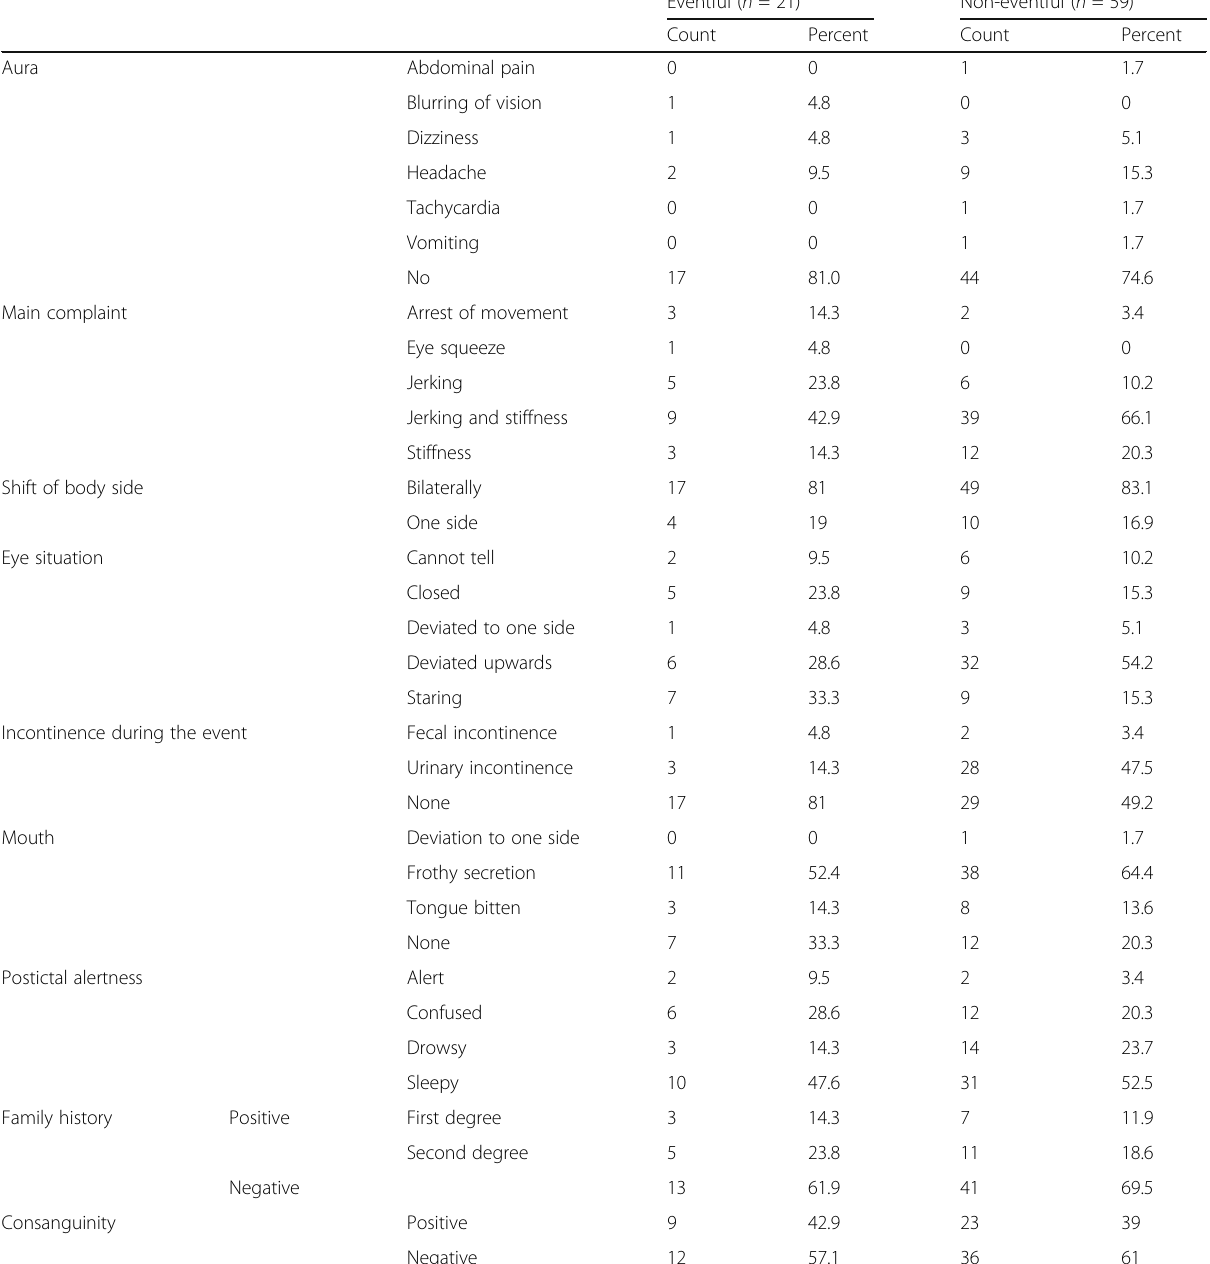
Eventful ( n = 21) Non-eventful ( n = 59) Count Percent Count Percent